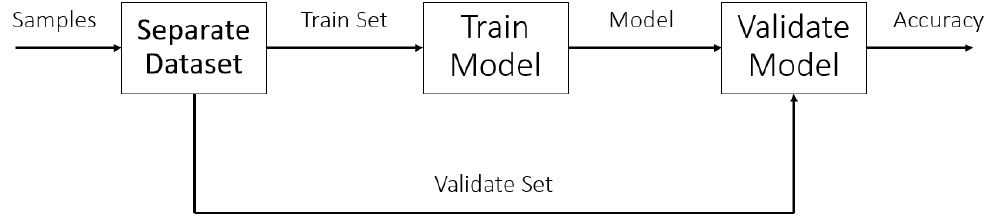
Figure 12. Flowchart for defining a predictive velocity